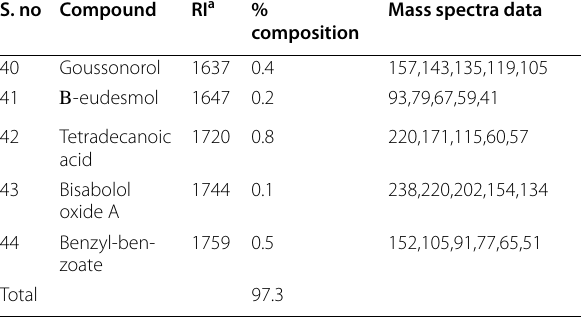
Table 5 Chemical composition of essential oil from